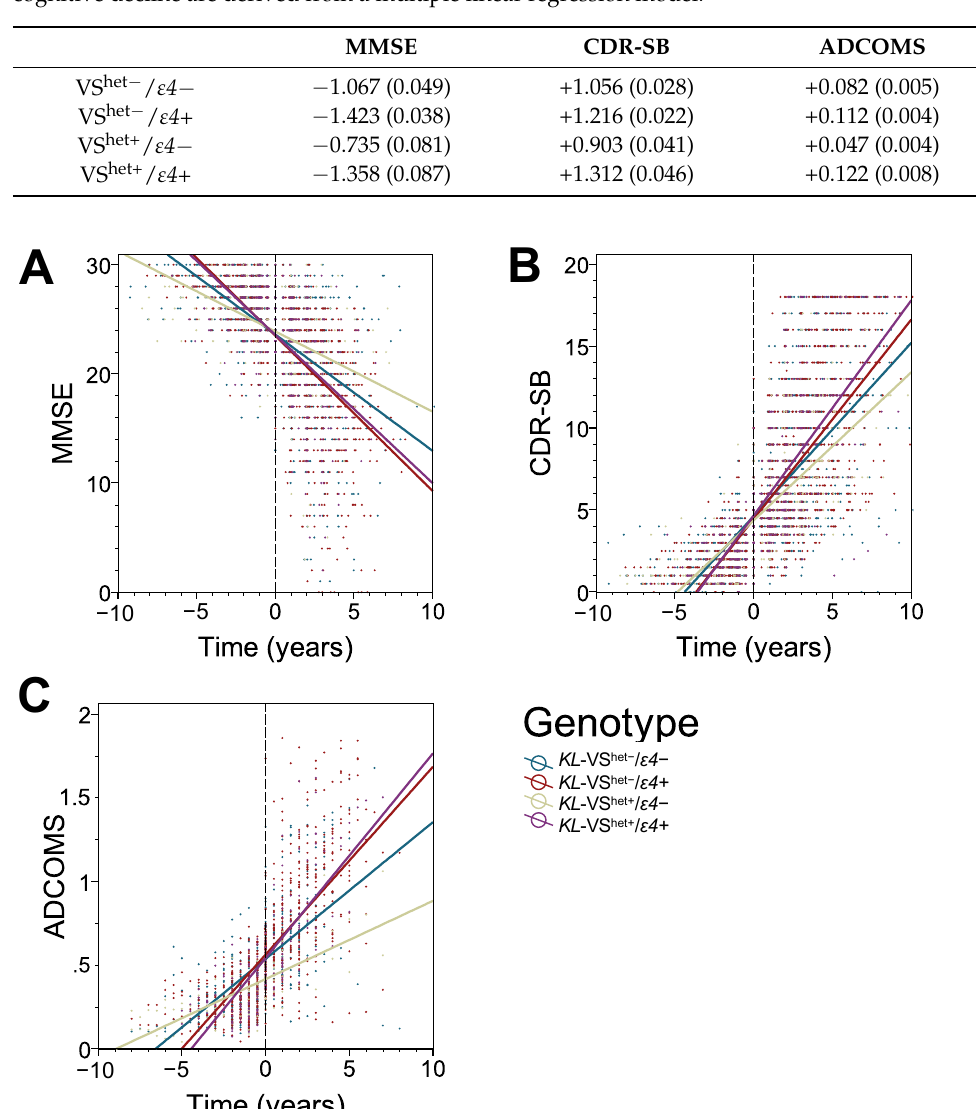
KL -VS het − / ε 4 − KL -VS het − / ε 4+